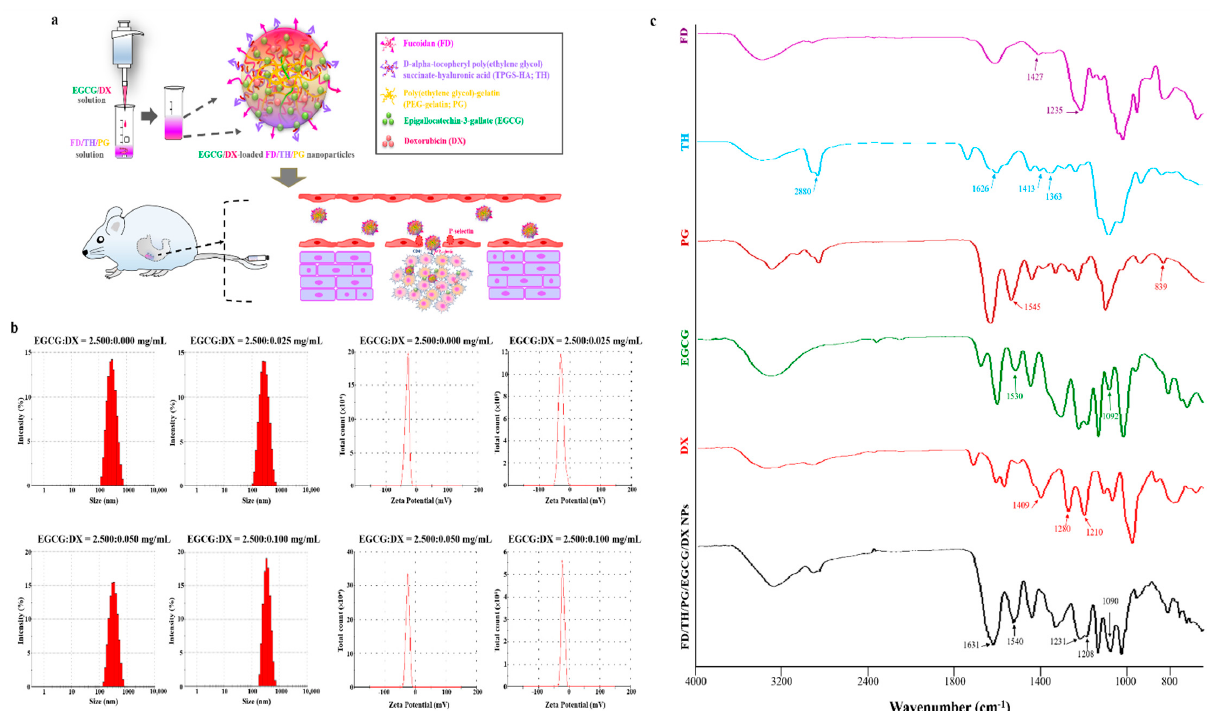
Figure 1. ( a ) NPs were prepared by adding EGCG/DX solution into FD/TH/PG solution under gentle stirring at 37 °C; the